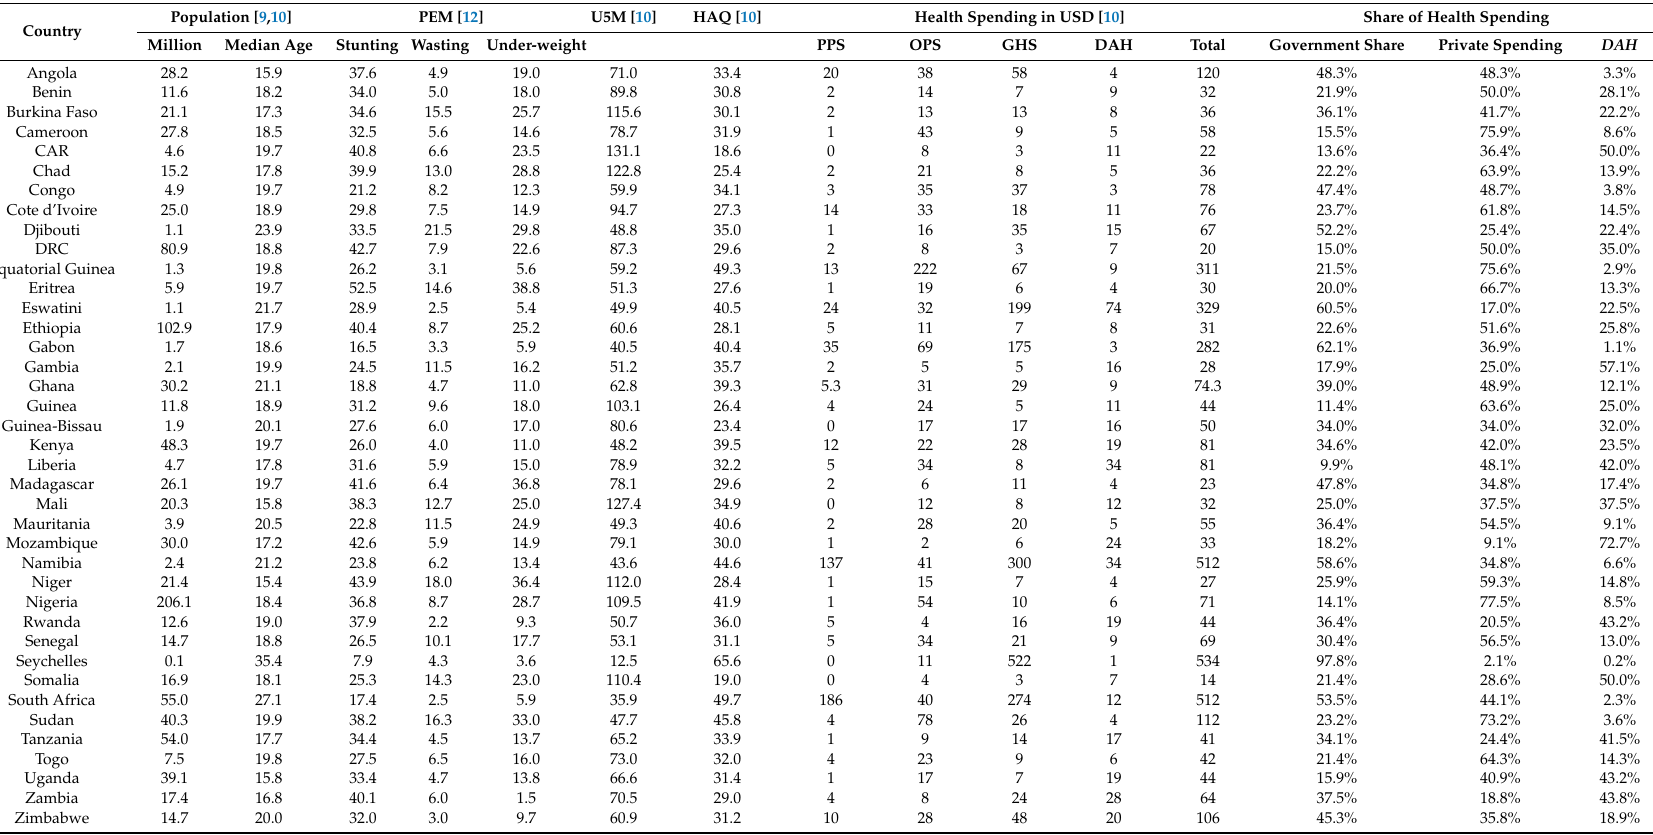
Table 1. Key health indicators in selected sub-Saharan African